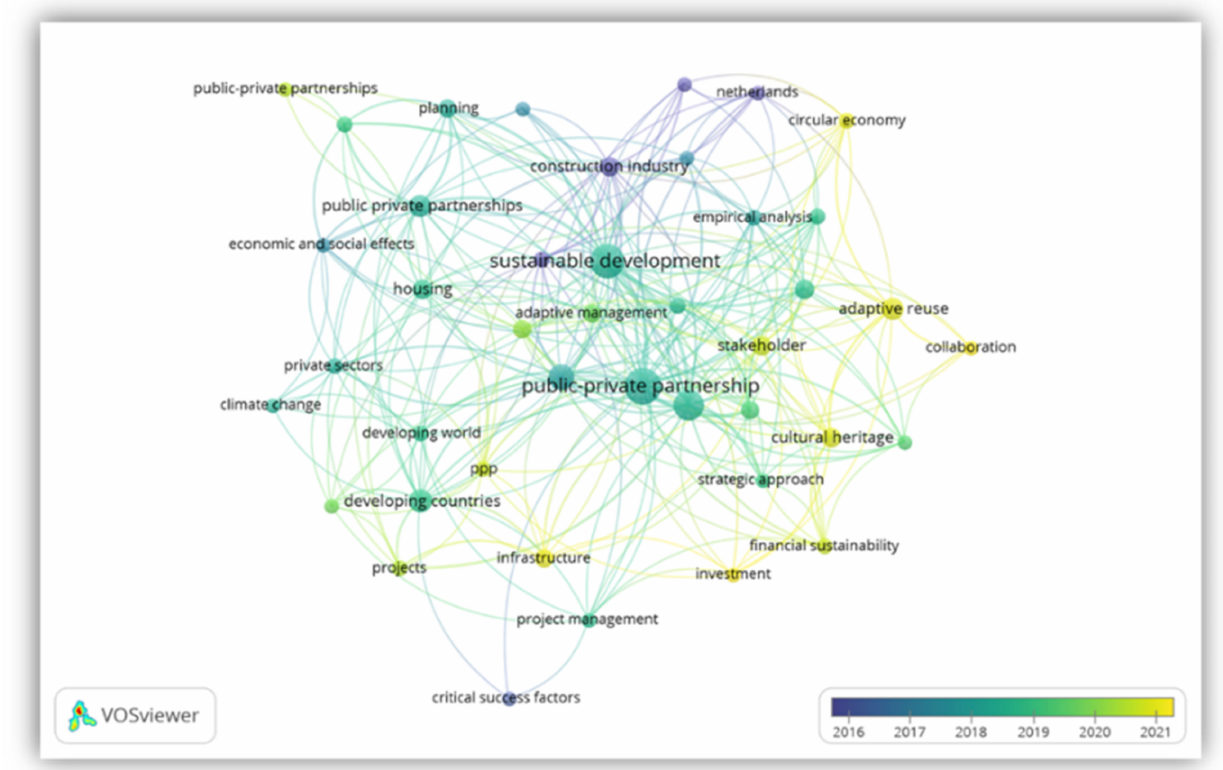
Figure 7. Temporal overlay of